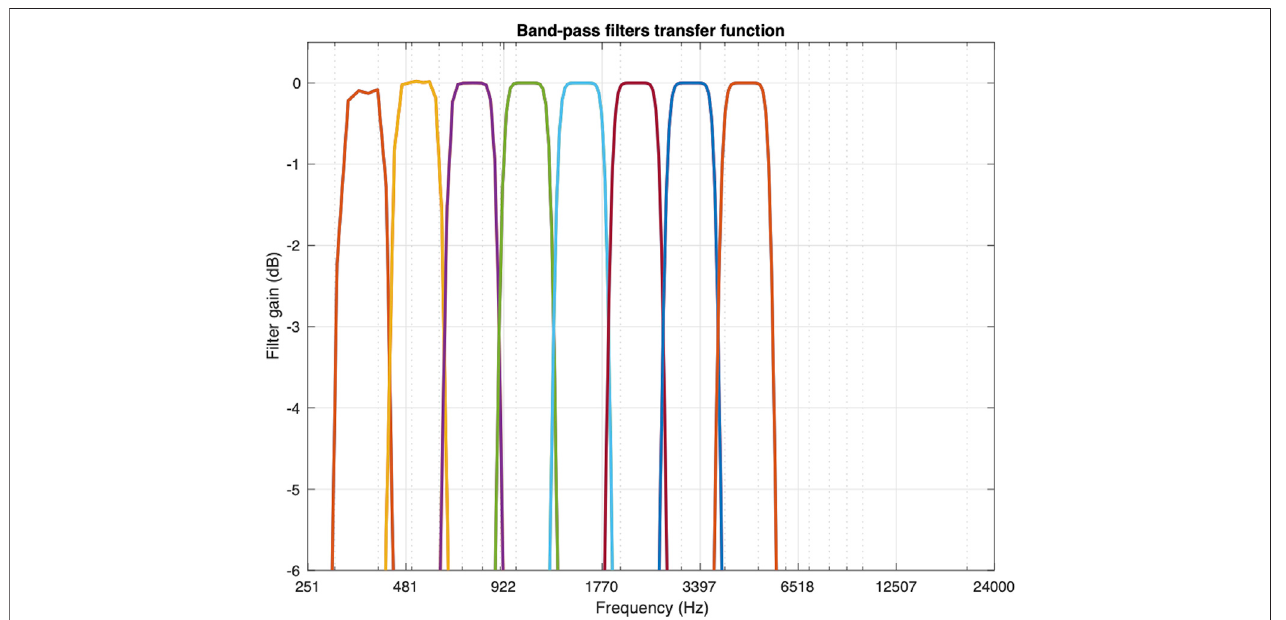
FIGURE 2 | The simulation of the CI in frequency domain. The eight frequency bands are clearly seen in the spectrum.